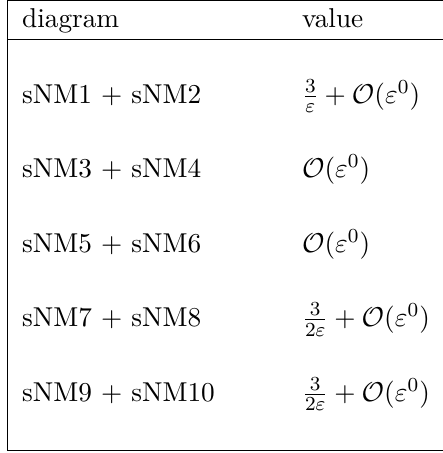
Table 2. UV divergences of the diagrams from figure 7 in units of C 2 ( R ) g